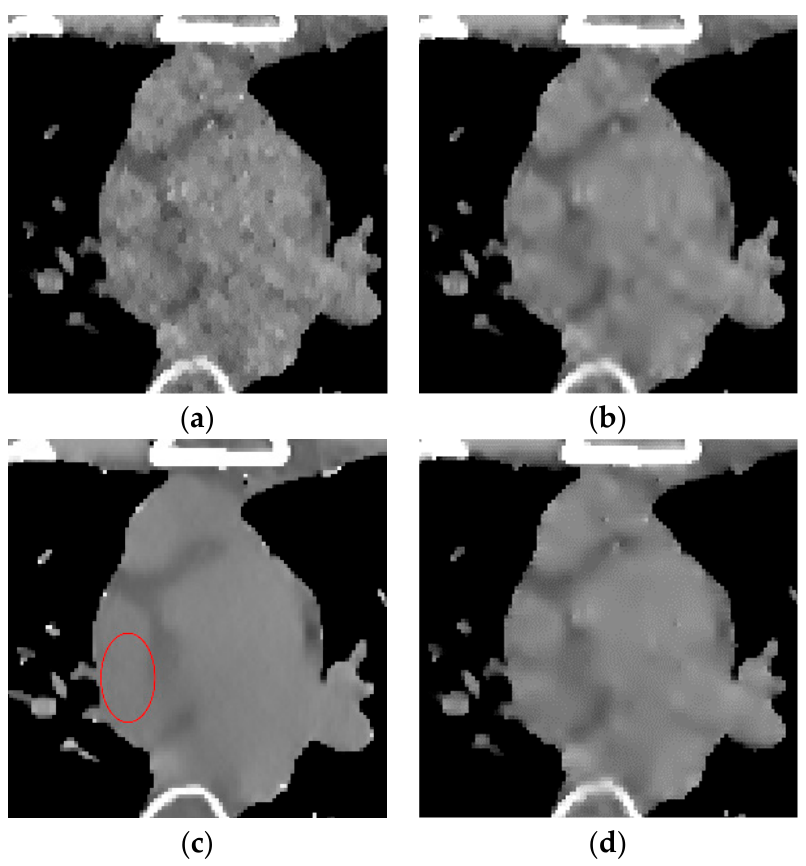
Figure 8. Enlarged local results of incident photon number 10 4 . ( a ) EP iterative reconstruction; ( b ) DCT image post-processing; ( c ) DL iterative reconstruction algorithm; ( d ) learning sparse transform.